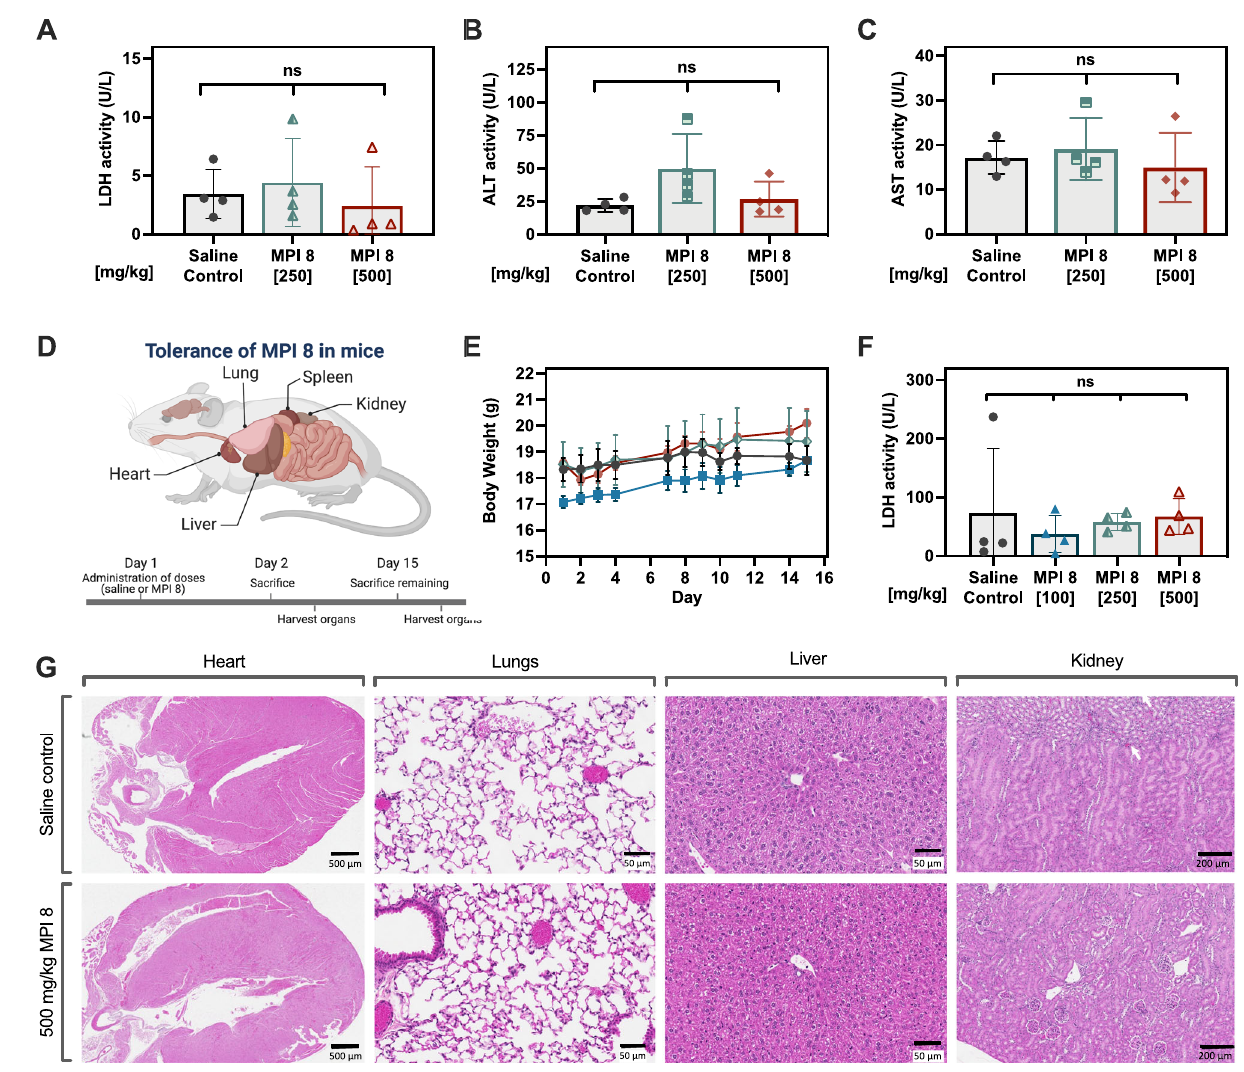
Fig. 7 | Tolerance ofMPI8 inmice.A – C MPI8 werewelltolerated in miceathigh doses. A – C LDH activity, ALT activity, AST activity in mice, respectively, after injecting MPI 8 intravenously. Mice were sacri fi ced after 24h (acute study). D Schematicrepresentationofmousechronictoxicitymodel.FemaleBALB/cmice were administered either saline or escalating doses of MPI 8, up to 500mg/kg. Miceweremonitored dailyand bodyweightsweremeasured.After 15days, serum wascollectedfromsacri fi cedmiceandanalyzed forLDHlevels.Miceinjected with